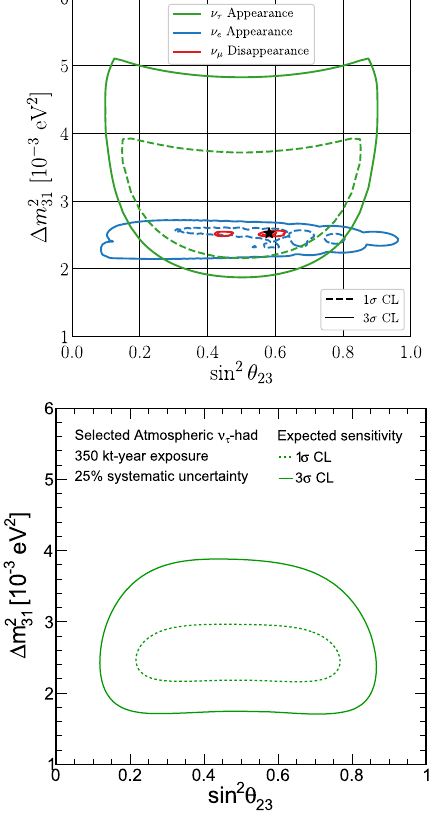
Fig. 38 The 1 σ (dashed) and 3 σ (solid) expected sensitivity for mea- suring Δ m 2 and sin 2 θ 23 using a variety of samples. Top: The expected 31 sensitivity for 7 years of beam data collection, assuming 3.5 years each in neutrino and antineutrino modes, measured independently using ν e appearance (blue), ν μ disappearance (red), and ν τ appearance (green). Adapted from Ref. [280]. Bottom: The expected sensitivity for the ν τ appearance channel using 350 kt · year of atmospheric exposure